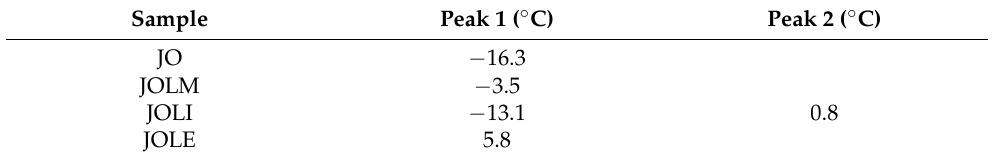
Table 4. DSC data for JO and polyols.